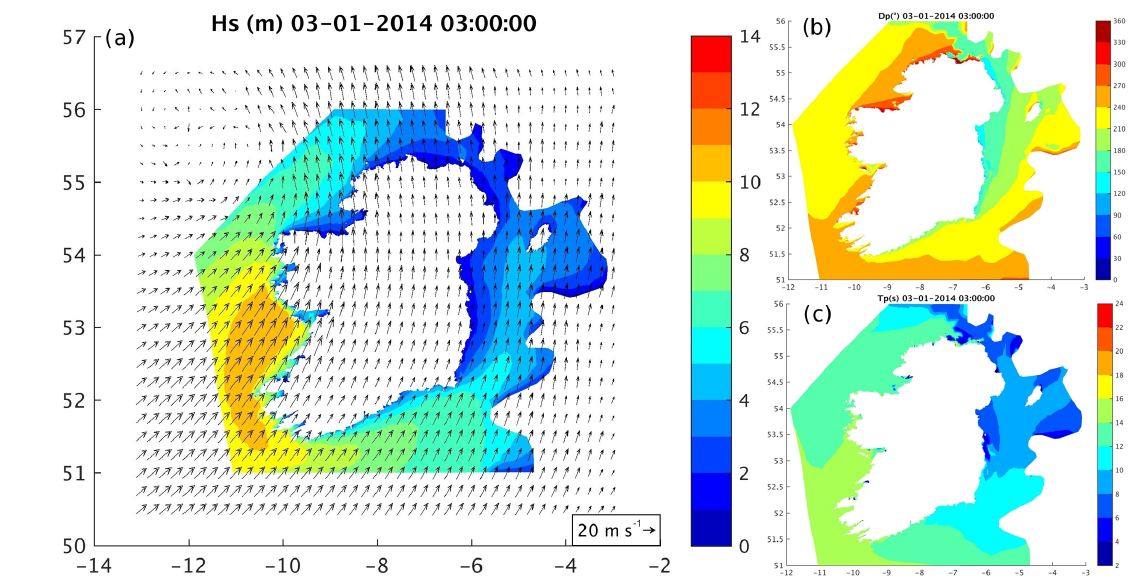
Figure 10. Maps of (a) significant wave height (m) with vectors representing wind speed (ms − 1 ) and direction ( ◦ ), (b) peak wave direction ( ◦ ), and (c) peak wave period (s) at 03:00UTC on 3 January 2014.